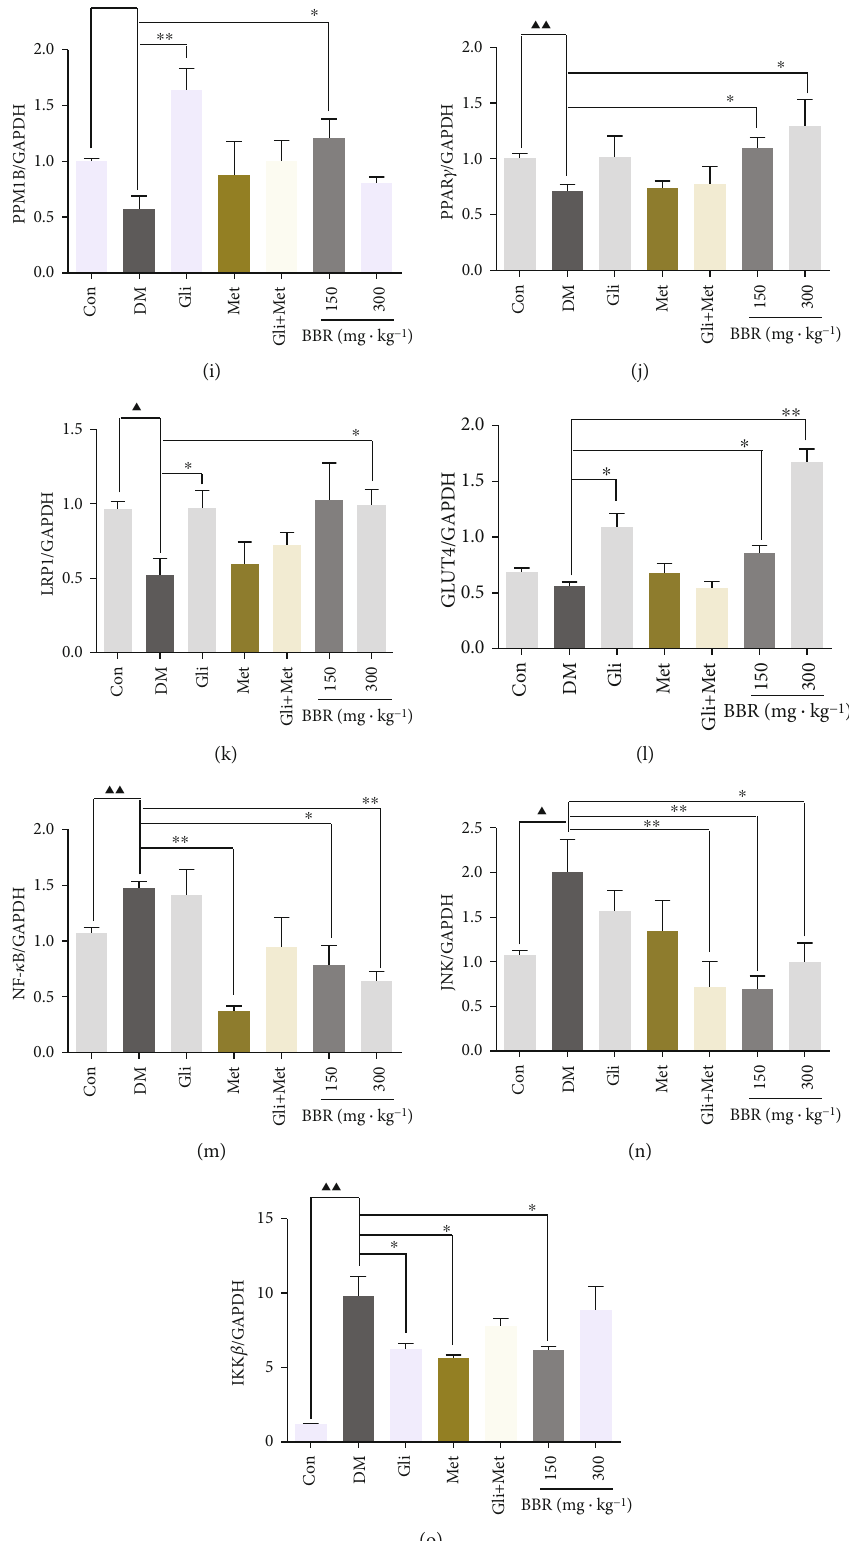
Figure 4: PPM1B was upregulated in the liver of ZDF rats. PPM1B, PPAR γ , LRP1, GLUT4, NF- κ B, JNK, and IKK β mRNA (a) and protein (b) relative expression with medication in ZDF rats. ▲ P < 0 : 05 and ▲▲ P < 0 : 01 , Con vs. DM; ∗ P < 0 : 05 and ∗∗ P < 0 : 01 , DM vs. experimental